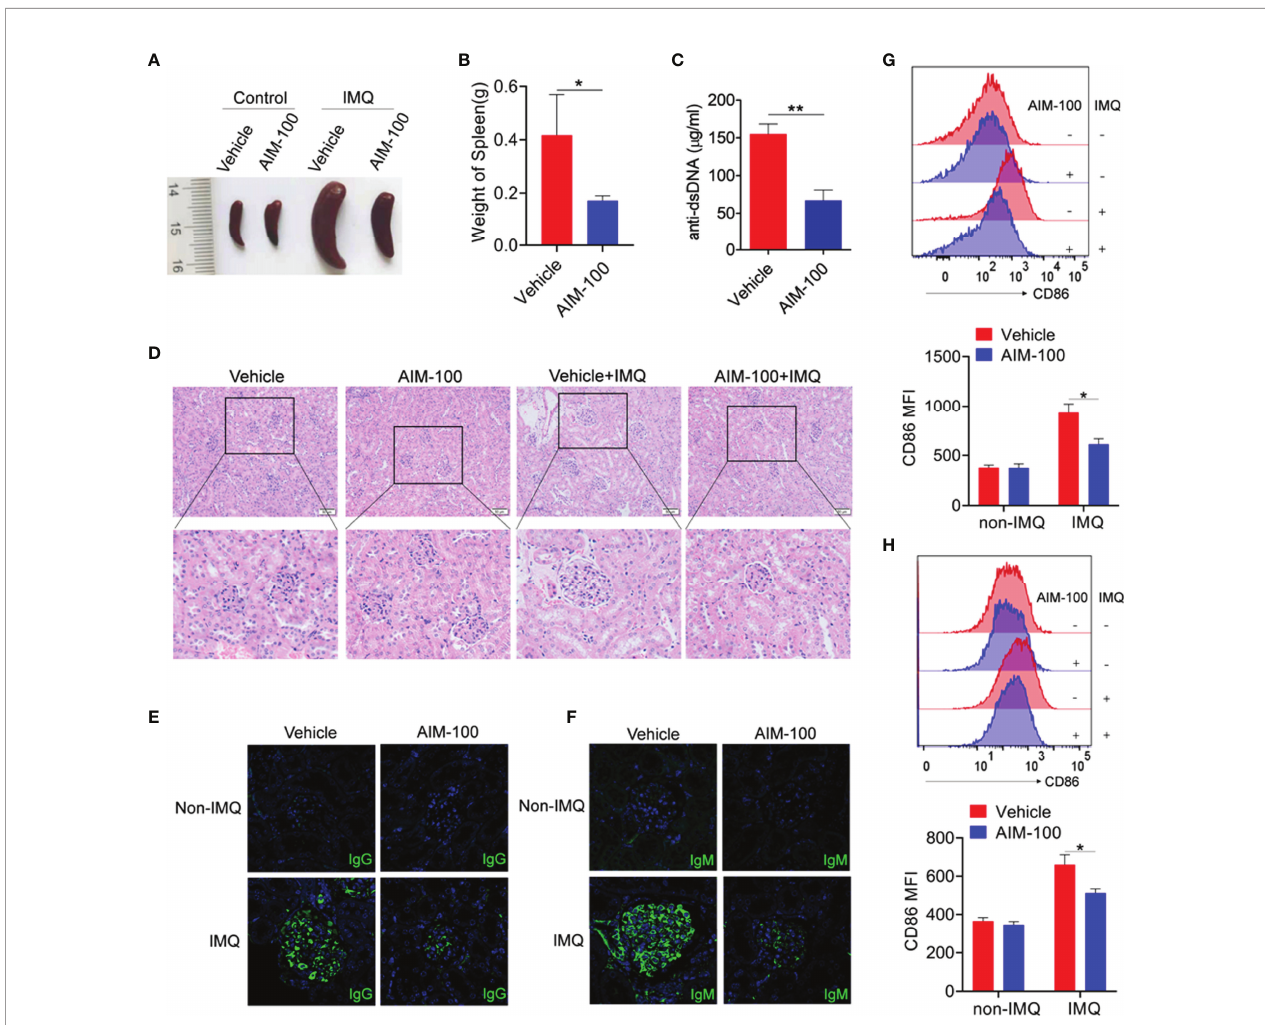
FIGURE 6 | The ACK1 inhibitor AIM-100 alleviates the conditions of IMQ-induced lupus-prone mice. (A) The representative spleen images in all group of mice. (B) The weight of spleens in IMQ mice treated with vehicle or AIM-100. (C) ELISA was performed to analysis of anti-dsDNA antibodies in serum. (D) H&E staining of the kidney sections from all groups of mice. (E, F) The IgG (E) and IgM (F) deposit in the kidney sections was detected by immuno fl uorescence. The scar strip represents 50 m m. (G, H) FACS analysis of the expression of CD86 on splenic macrophages (G) and DCs (H) . Results represented as mean ± SEM (n=6 mice/ group). * p < 0.05, ** p < 0.01, as determined by ANOVA or Student ’ s t